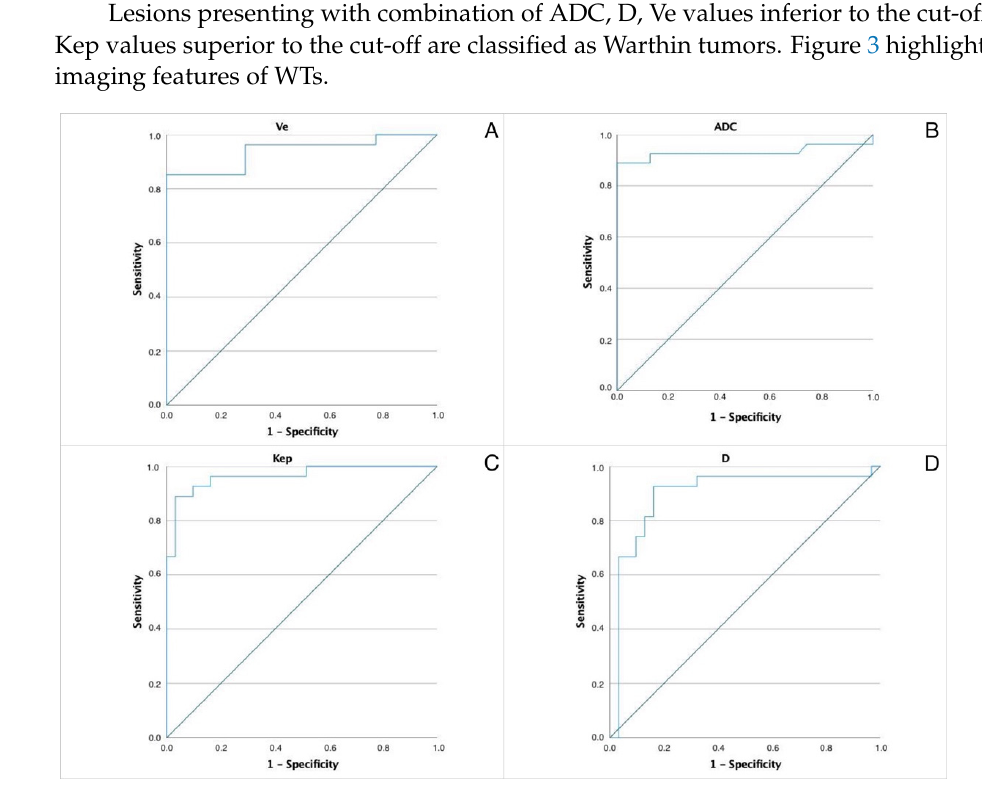
Figure 2 . Pleomorphic adenoma (arrow) in superficial lobe of the right parotid. ( A ) ADC map. Le- sion presents with high signal intensity correlating with lack of diffusion restriction. ( B ) Time